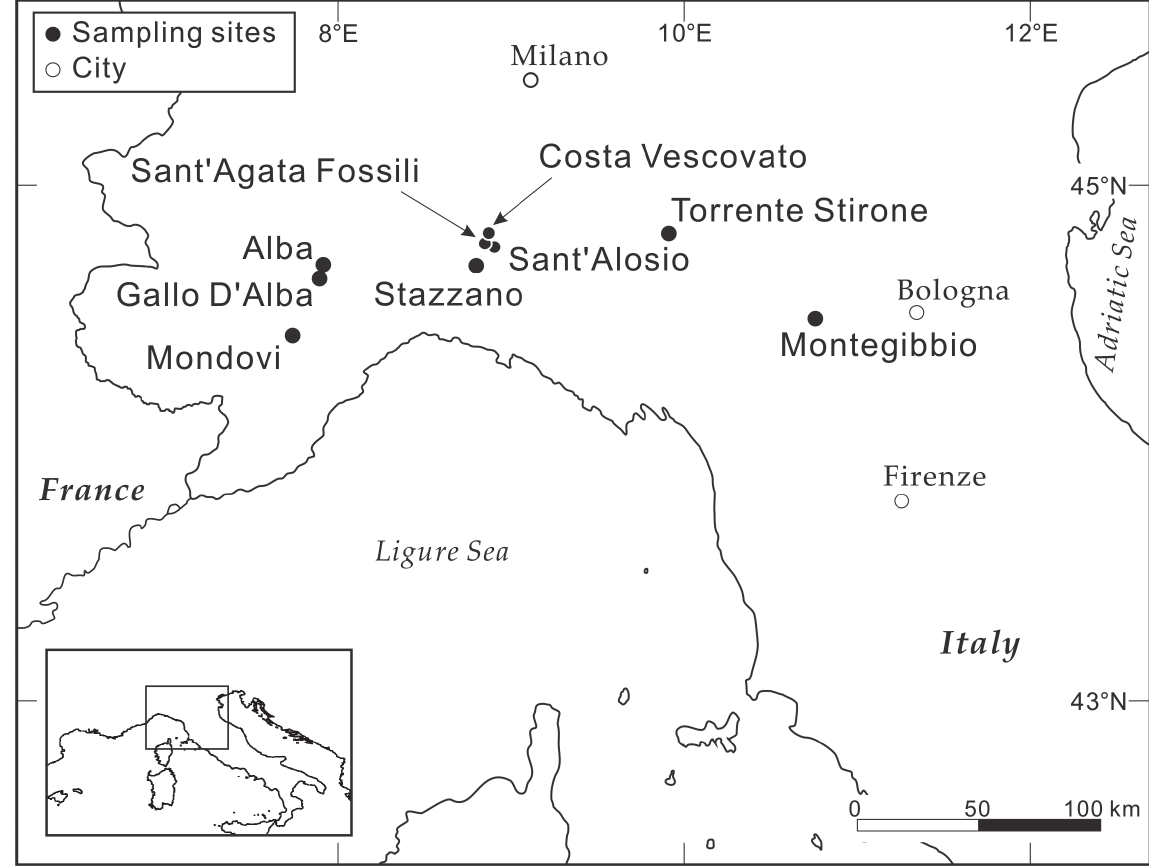
Fig. 1. Map showing the sampling